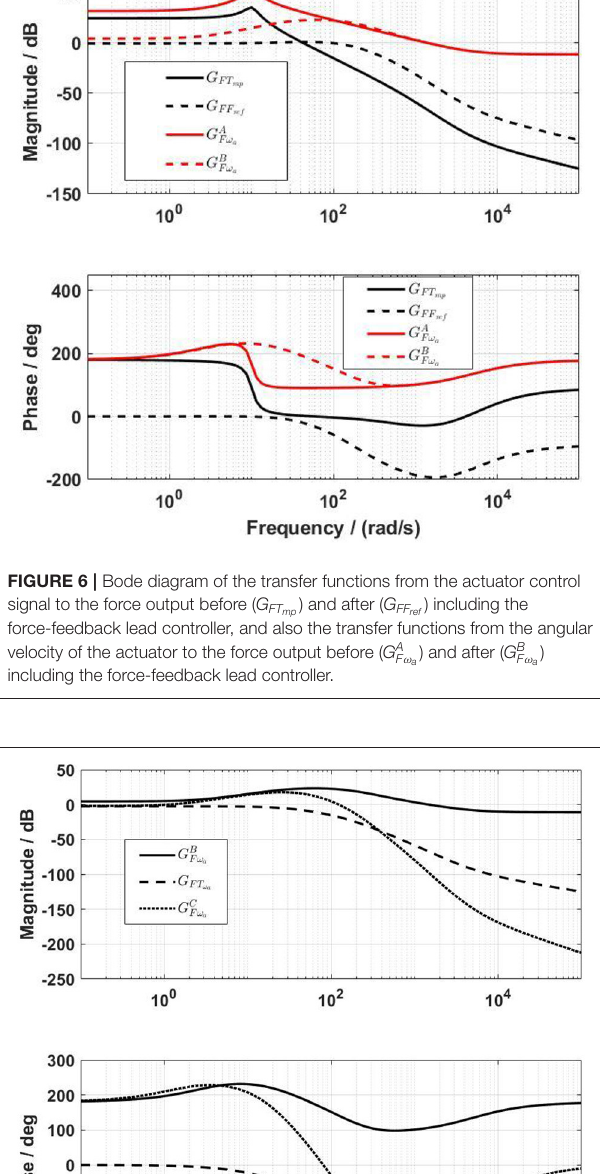
FIGURE 9 | Stability analysis of the closed-loop system using loop gain G Lo (Equation 16). The gain margin is 27.4 dB (at 824 rad/s), and the phase margin is 61.5 ◦ (at 103 rad/s). The blue dashed line shows the modulus margin of 0.79.